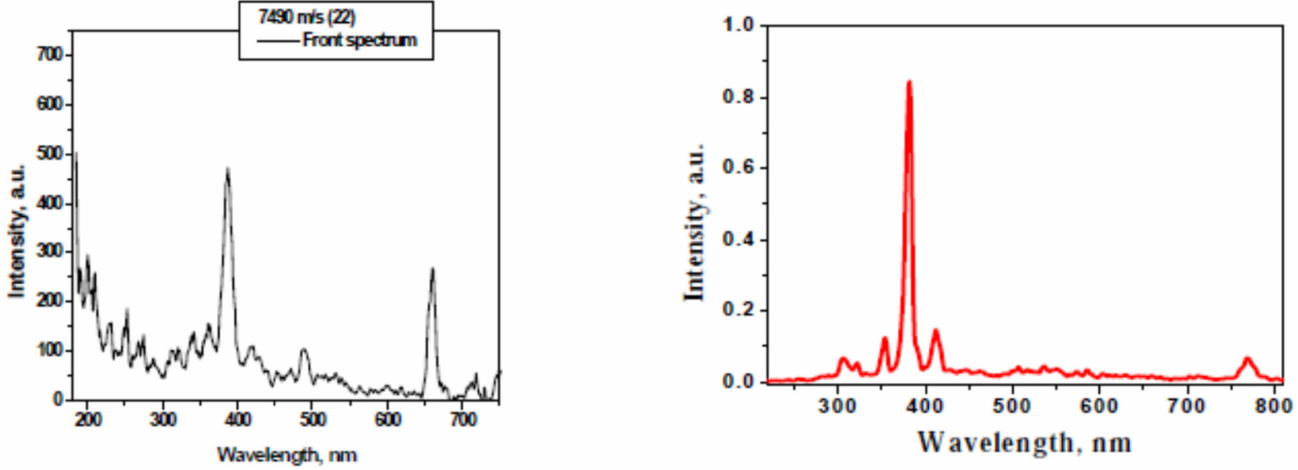
Figure 57. Emission intensity at the shock front for Cases 3 ( left ) and 4 ( right ) of Table 6 (from [55]).